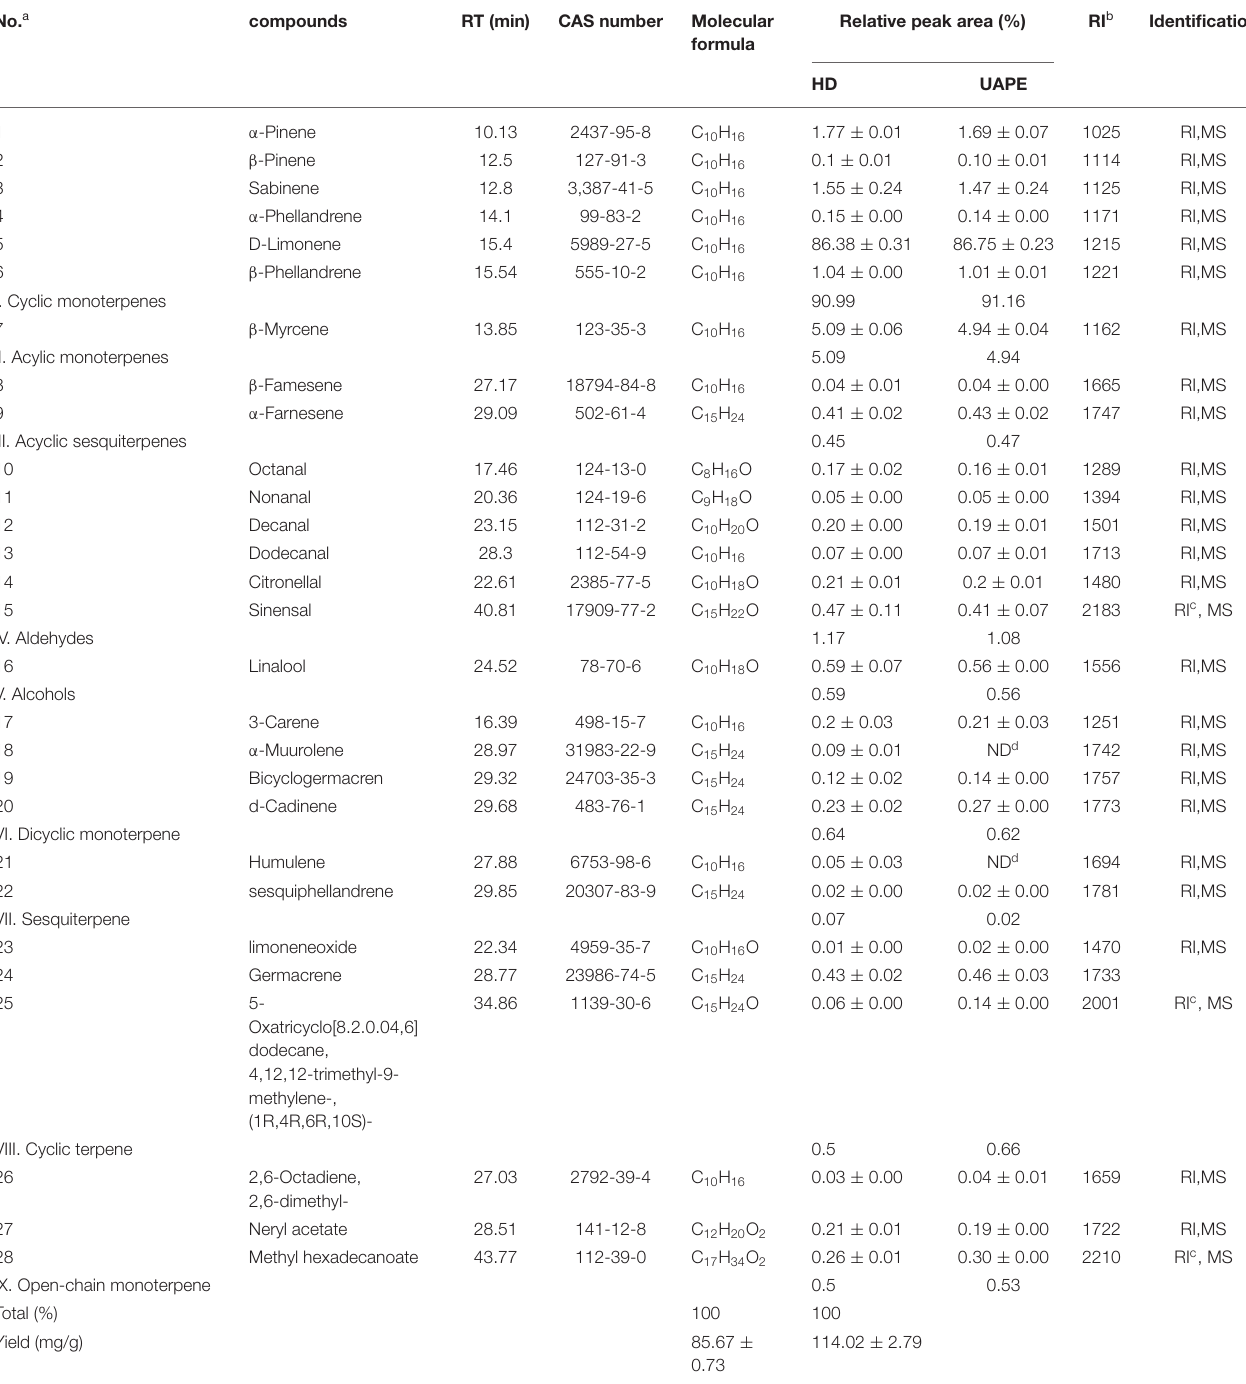
TABLE 5 | Chemical composition of TCEO by GC-MS